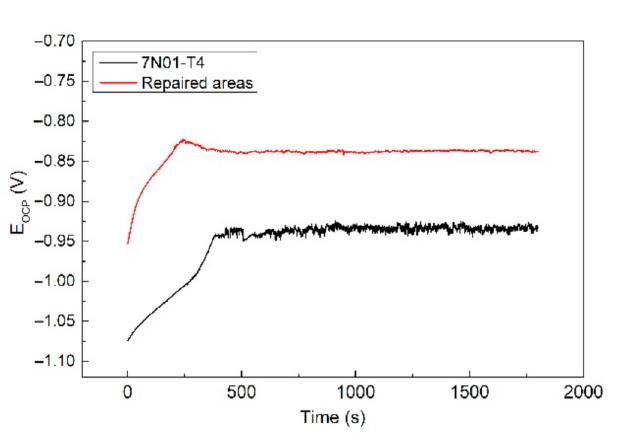
Figure 10. The open circuit potential of the samples before the alternate immersion